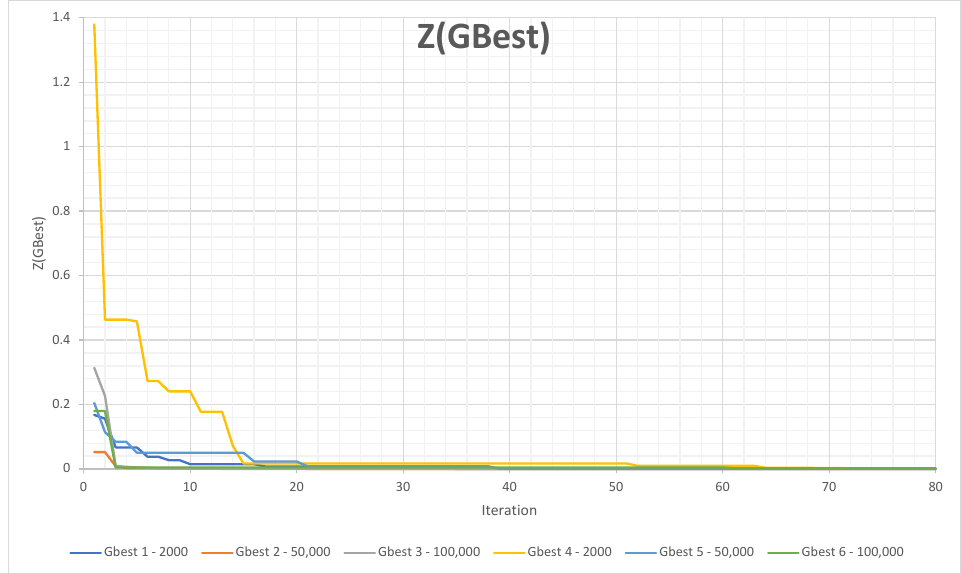
Figure A8. Objective value of the equivalent problem for general best for each